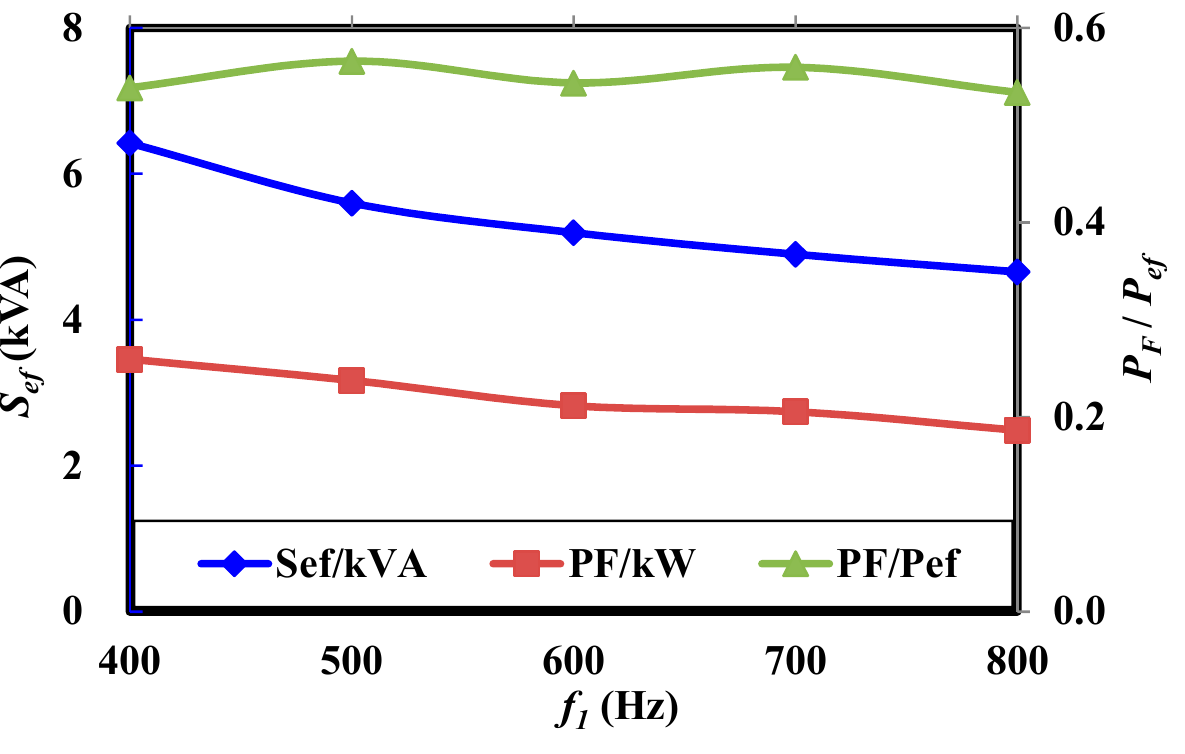
Figure 10. The curve of input apparent power S ef , output power P F , and transformation efficiency changing with frequency.